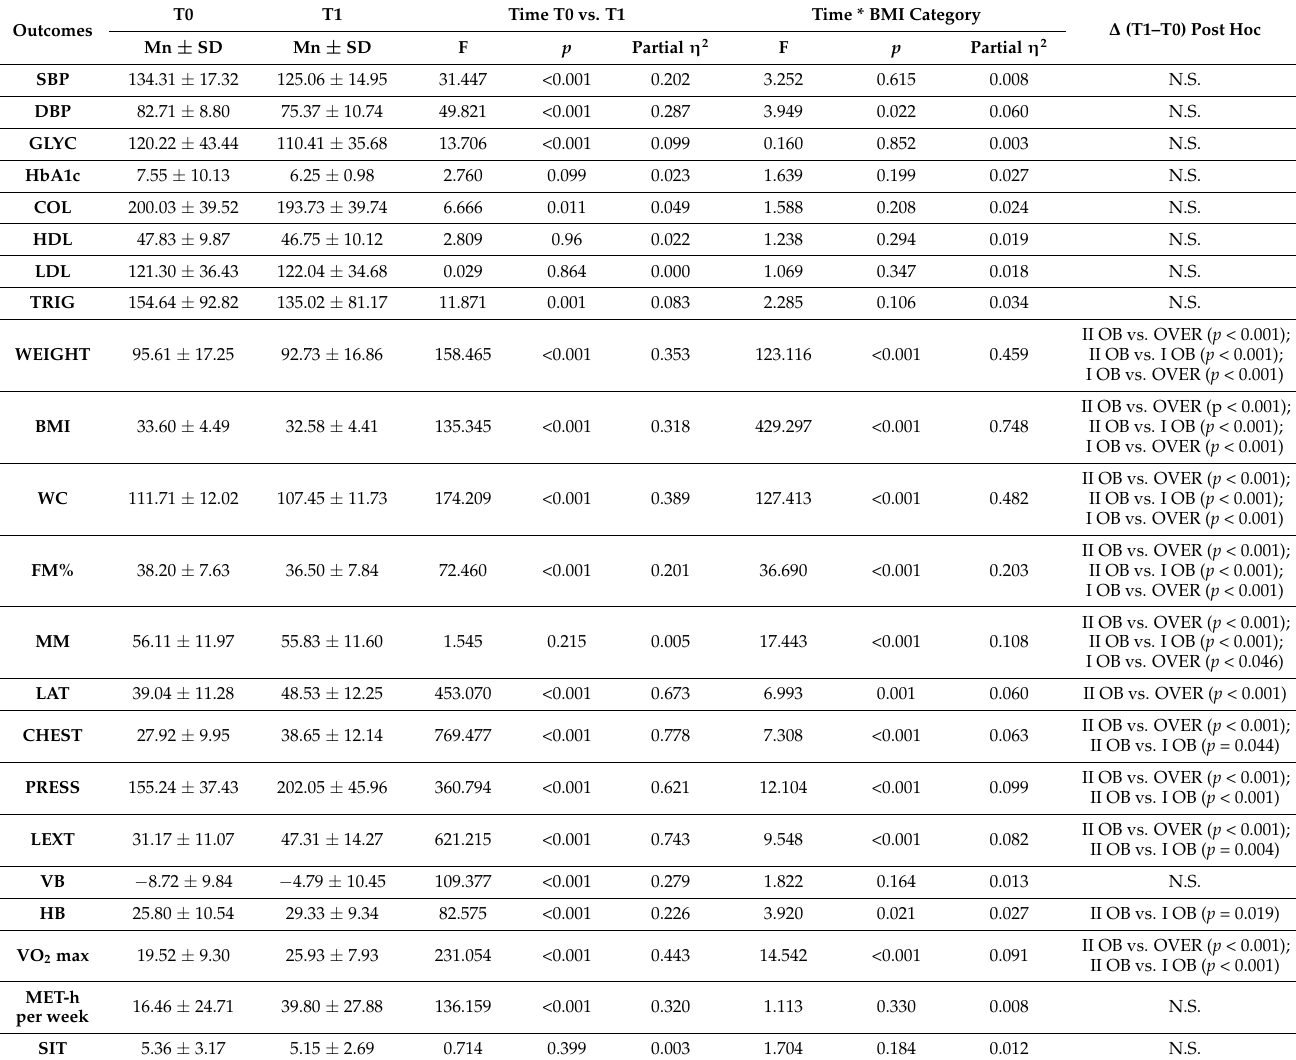
Table 2. Repeated-measures multivariate analysis of variance values, using BMI ( a ), PAL ( b ) and SIT ( c ). a . Repeated-measures multivariate analysis of variance to analyze differences in all variables between T0 and T1, using BMI categories as a between factor. Data are presented as means ± SDs. Statistical significance was set for p -values ≤